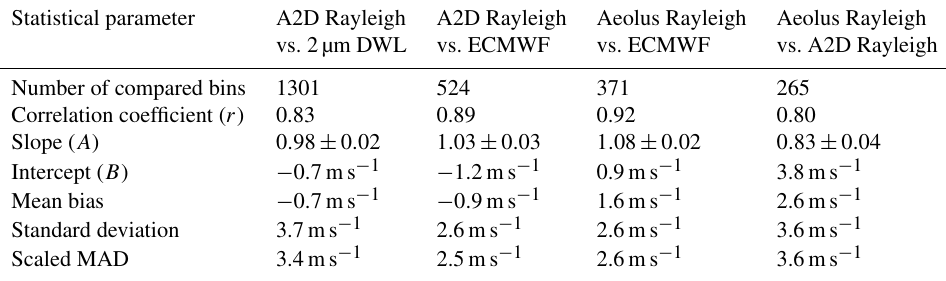
Table 4. Results of the statistical comparison between the A2D Rayleigh, the Aeolus Rayleigh and the ECMWF LOS* wind speeds for all of the underflights performed during the WindVal III campaign. See the corresponding scatterplots in Fig. 11 (that refer to the last three columns in this table). The first column includes the data from Table 3 after the conversion of the wind speeds to the satellite’s LOS* (37 ◦ off-nadir angle). Please note that different horizontal and vertical averaging lengths apply to the different comparisons (see text for